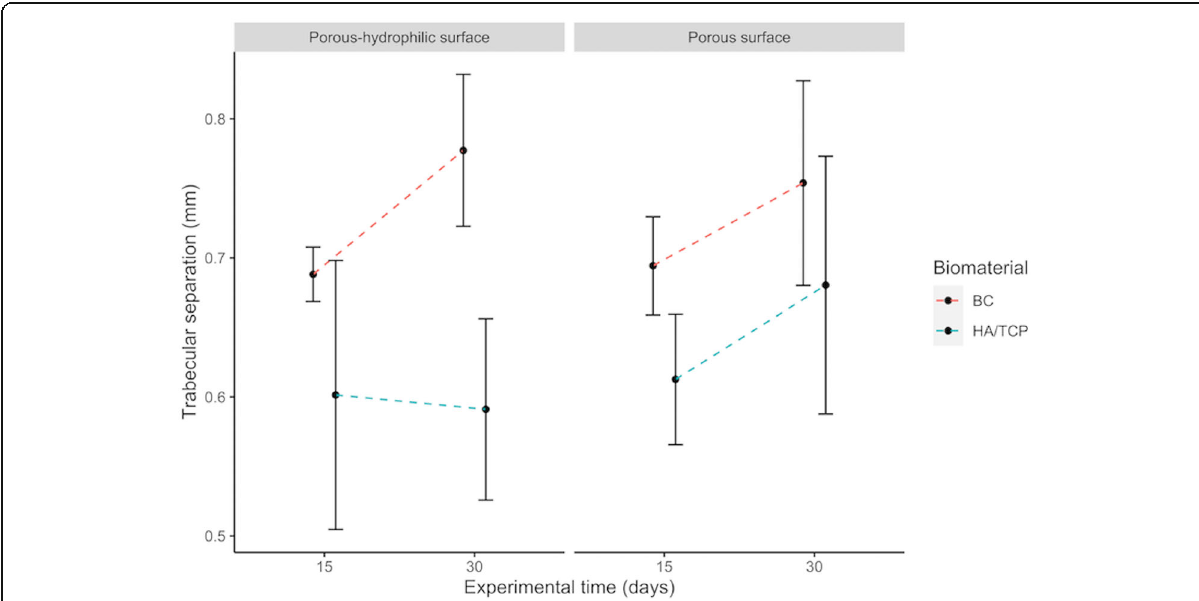
Fig. 3 Interactions among implant surfaces, bone substitute material or blood clot and experimental period on trabecular separation. Error bars represent the standard deviation around the means